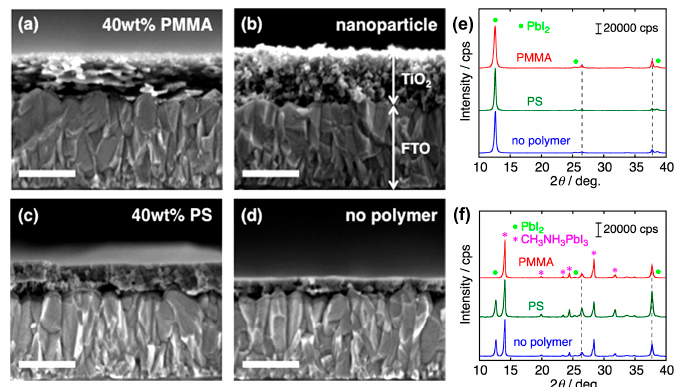
Figure 14. Cross-sectional SEM images of ( a ) TiO 2 (40 wt %-PMMA); ( b ) TiO 2 (nanoparticle); ( c ) TiO 2 (40 wt %-PS); and ( d ) TiO 2 (without polymer) on FTO/cTiO 2 substrates. Scale bars are 200 nm, and Wide-angle XRD patterns of ( e ) PbI 2 and ( f ) perovskite MAPbI 3 films deposited on FTO/cTiO 2 /TiO 2 (40 wt %-PMMA) (red line), FTO/cTiO 2 /TiO 2 (40 wt %-PS) (green line), and FTO/cTiO 2 /TiO 2 (no-polymers) (blue line). Symbols of green solid circle (•) and pink star (*) represent the XRD diffraction peak position of PbI 2 and CH 3 NH 3 PbI 3 [128]. Copyright © 2015, American Chemical Society.